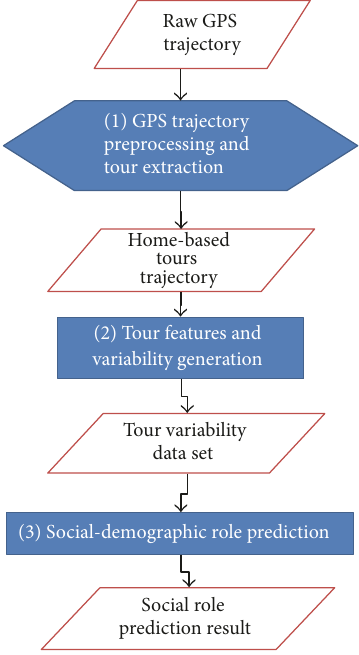
Figure 1: Methodology